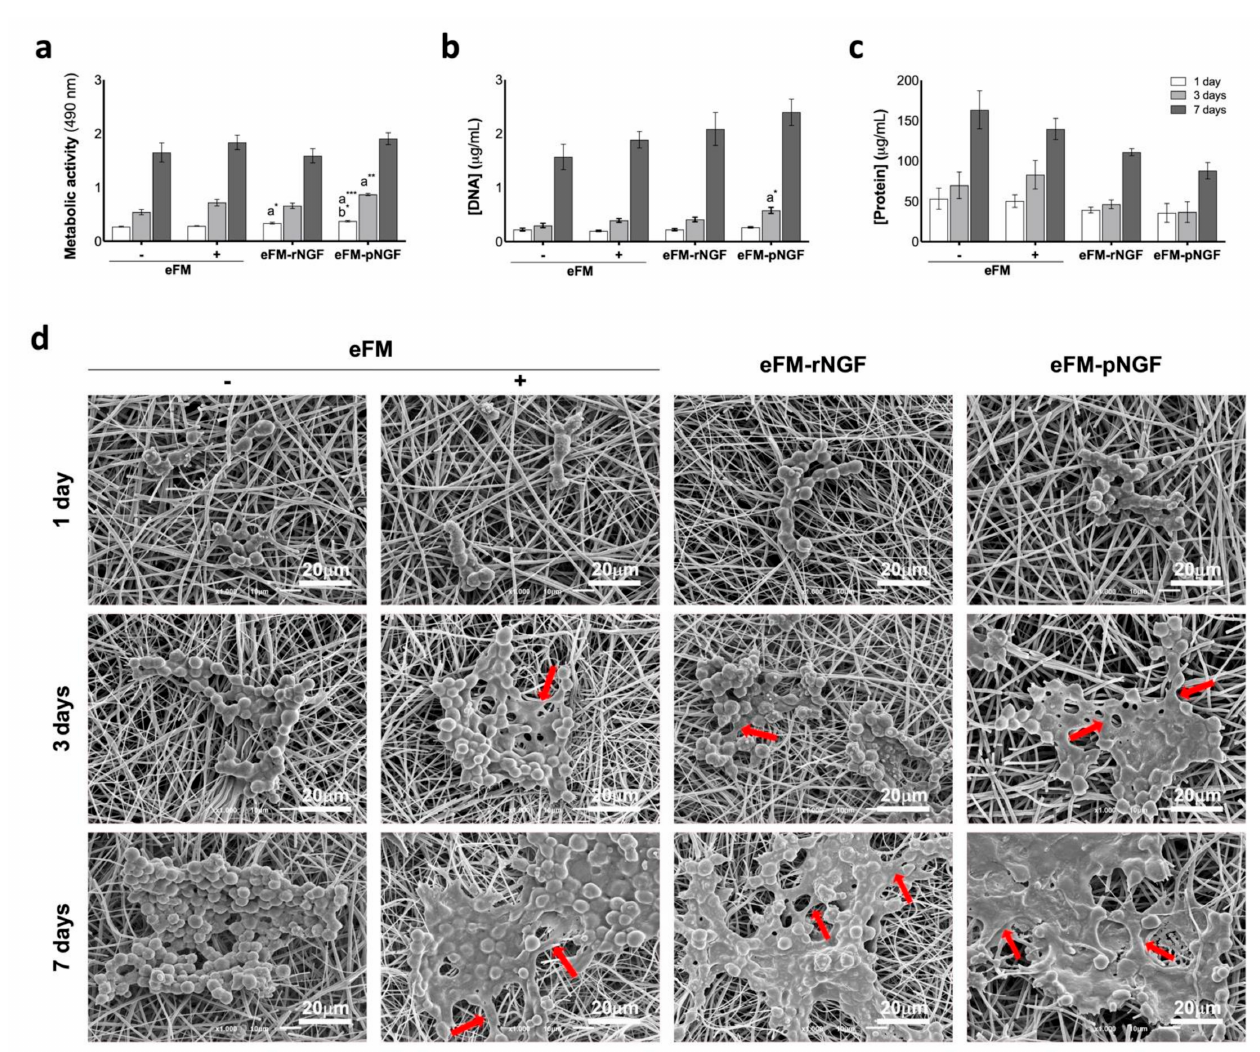
Figure 2. Biochemical performance of PC12 cells. (Top): Biochemical performance (i.e., metabolic ac- tivity ( a ), proliferation ( b ), and protein synthesis ( c ) of the PC12 cells cultured on eFM functionalized with NGF β from different sources, under basal medium and at defined time points (1,3 and 7 days). eFMs cultured with PC12 cells under basal (eFM − ) or neuronal differentiation media (eFM+) were used as controls. The one-way ANOVA with the Tukey’s HSD post hoc test were applied ( p < 0.01): a represents significant differences compared to eFM − and b represents significant differences com- pared to eFM+; * p < 0.01; ** p < 0.001; *** p < 0.0001; (Bottom): Morphological analysis of the PC12 cells on different culture condition, along culturing time, by scanning electron microscopy (SEM) ( d